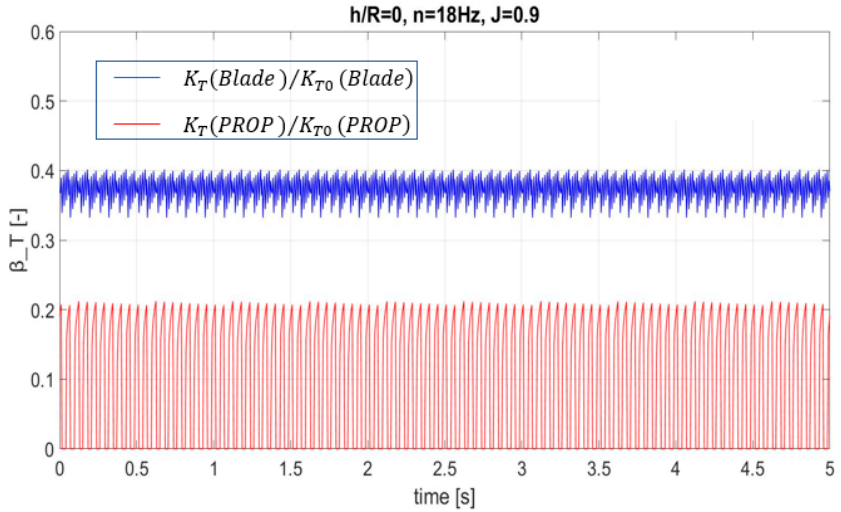
Figure 20. Time series of the computed thrust coe ffi cient for a single blade and the propeller for J = 0.9, h / R = 0, n = 18 Hz, K ( Blade ) / K ( Blade ) is the thrust loss coe ffi cient for a single blade, and K T ( PROP ) / K T 0 ( PROP ) is the thrust loss coe ffi cient for the whole propeller.